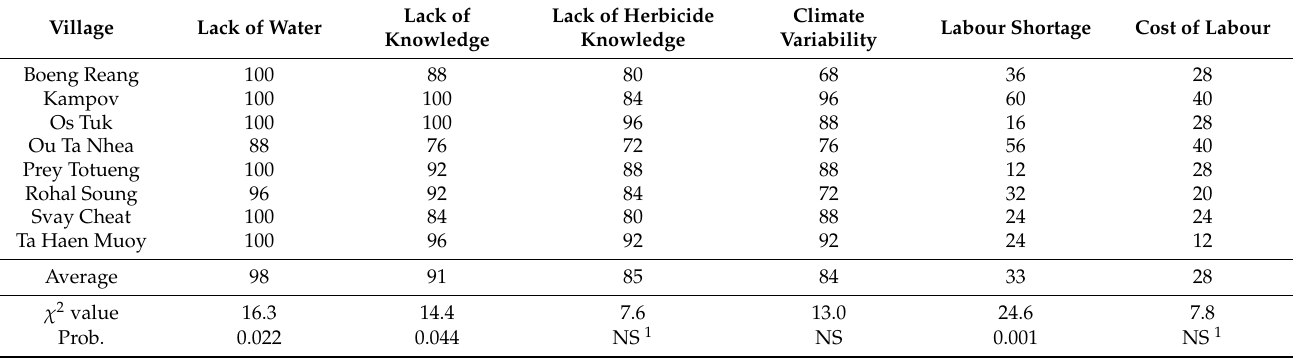
Table 9. The main factors affecting weed management in rice fields according to farmers (% of households).